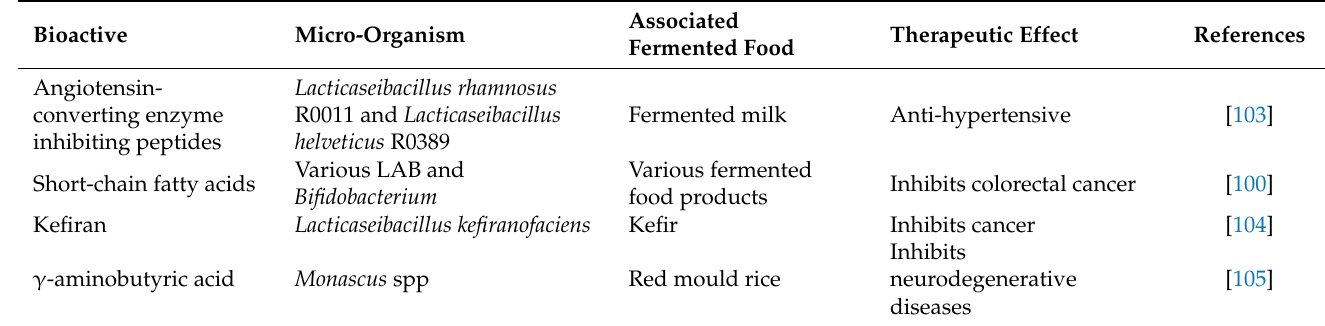
Table 1. Bioactive metabolites found in fermented foods and their activity.